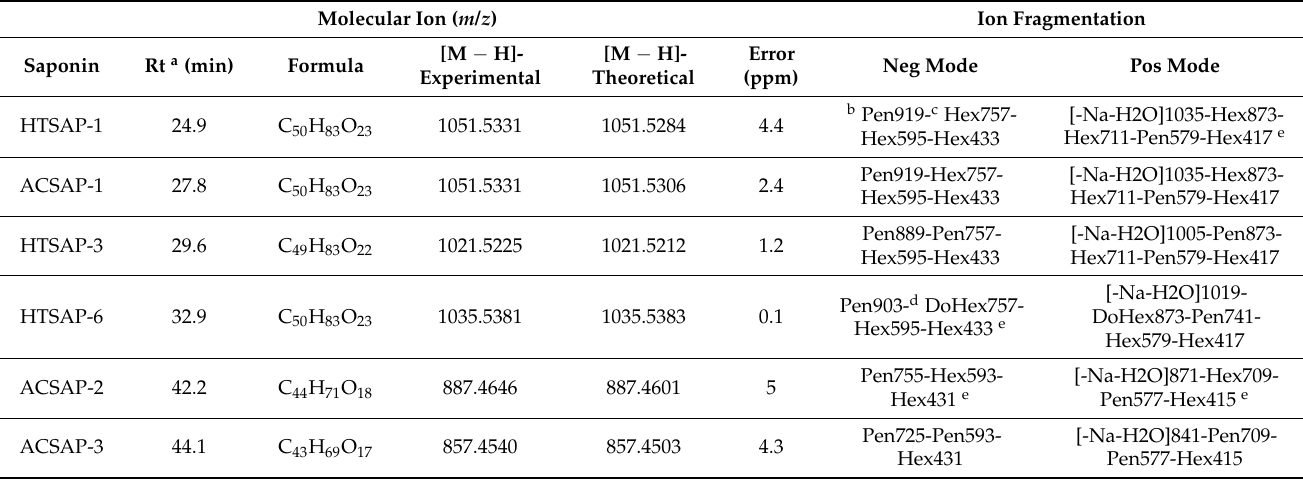
Table 2. Characterization of the saponins tentatively identified by LC-MS (+/ − ) of the ethanolic extracts of different organs from A. acutifolius